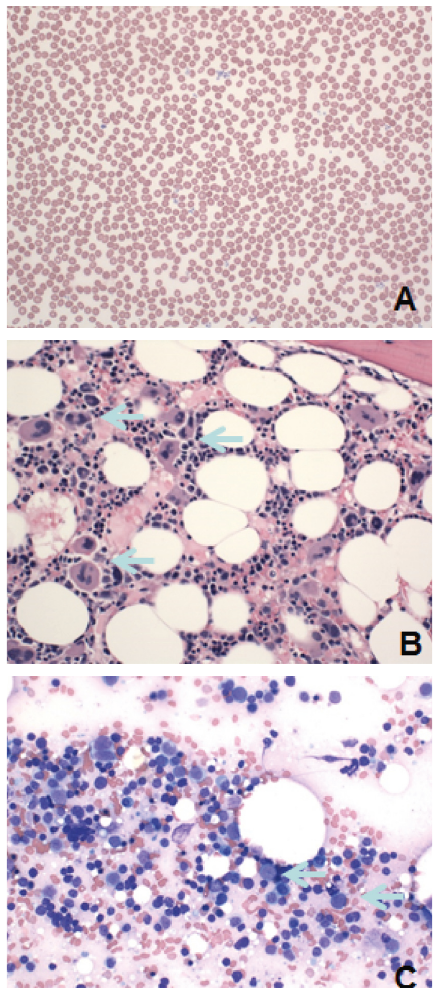
Figure 1: Peripheral blood smear and bone marrow studies. (a) Peripheral blood smear shows severe neutropenia with no neu- trophils seen in this field (hematoxylin and eosin stain; × 400), (b) bone marrow biopsy with normal cellularity, increased megakar- yocytes (blue arrows), and severe decrease in neutrophils (hema- toxylin and eosin stain; × 400), and (c) bone marrow smear displays severely decreased segmented granulocytes and increased blasts (blue arrows; Wright–Giemsa stain ×